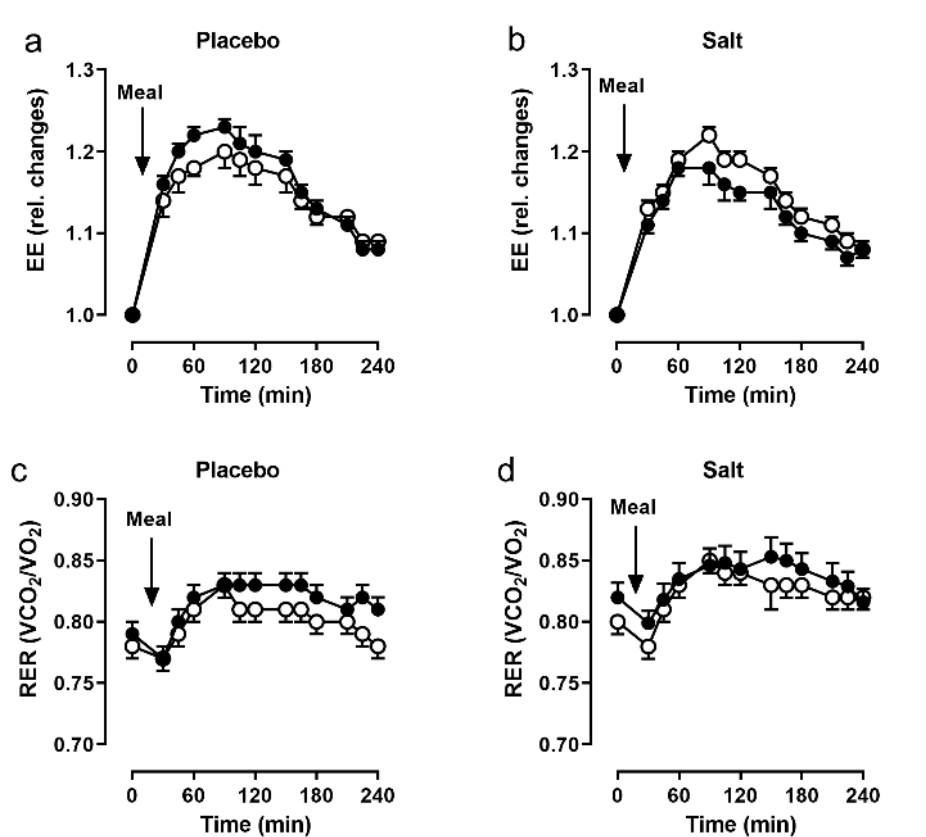
Figure 3. Indirect calorimetry. Energy expenditure (EE) and respiratory exchange ratio (RER) following a 441 kcal breakfast, before (open circles) and after (closed circles) 2 weeks of placebo ( n = 19, ( a , c )) and salt ( n = 19, ( b , d )). Data as mean and SEM. Body weight, fat mass, fat-free mass, body cell mass, extracellular water and total body water were not significantly different after the 2 week intervention, neither within nor between groups (Table 2). Table 2. Body composition, dietary intake, urine analysis, and cardiovascular parameters of healthy volunteers before and after 2 weeks of placebo or salt 1